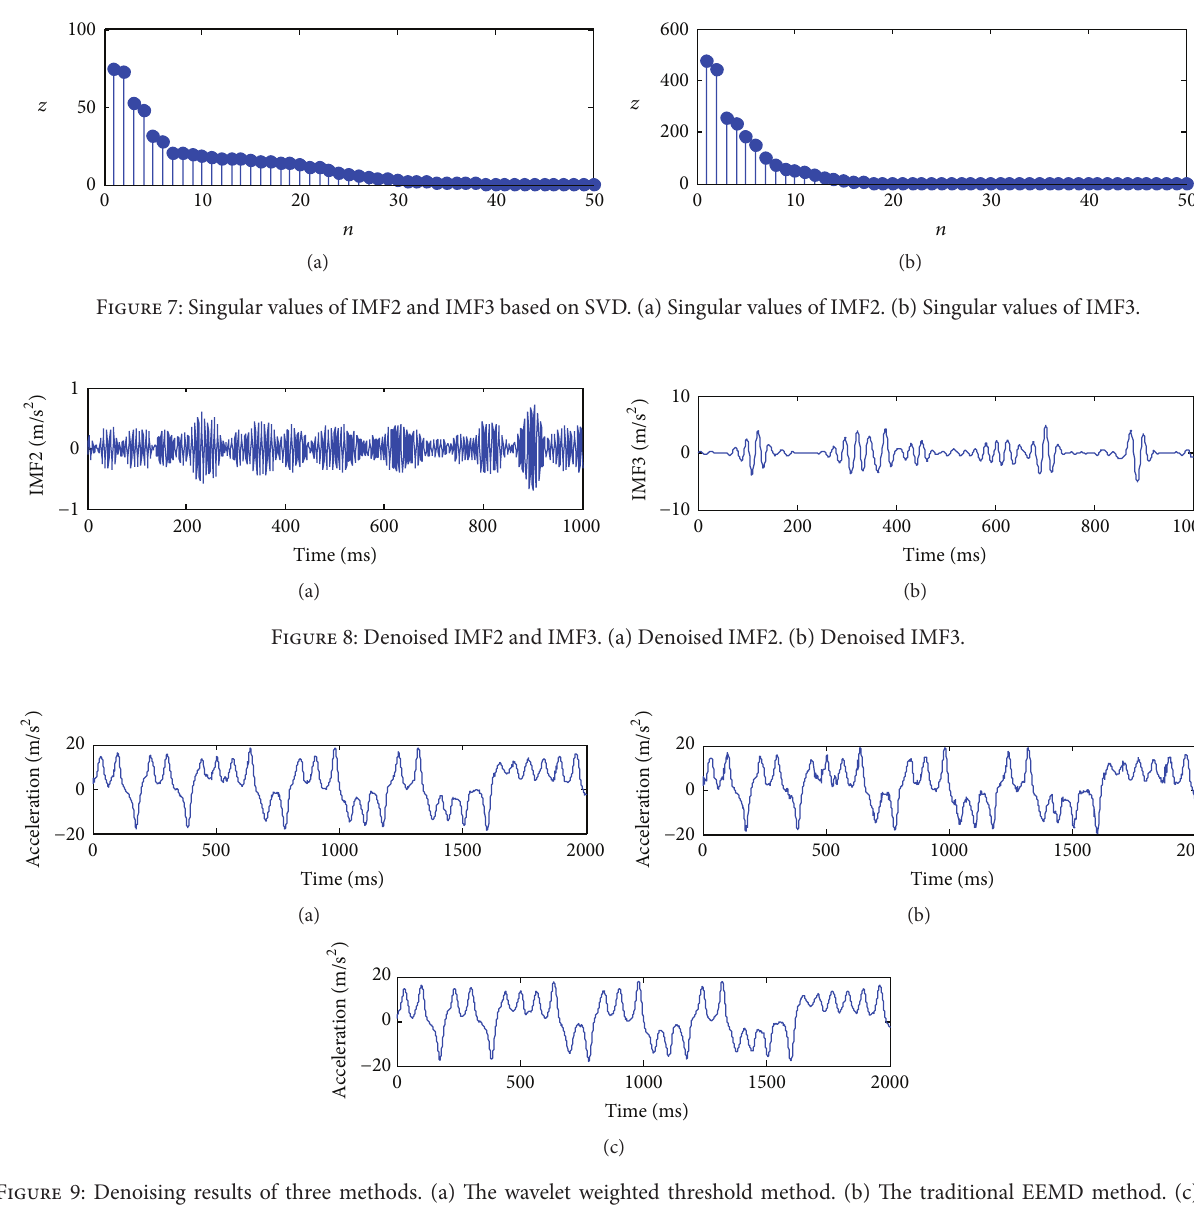
Figure 9: Denoising results of three methods. (a) The wavelet weighted threshold method. (b) The traditional EEMD method. (c) The proposed